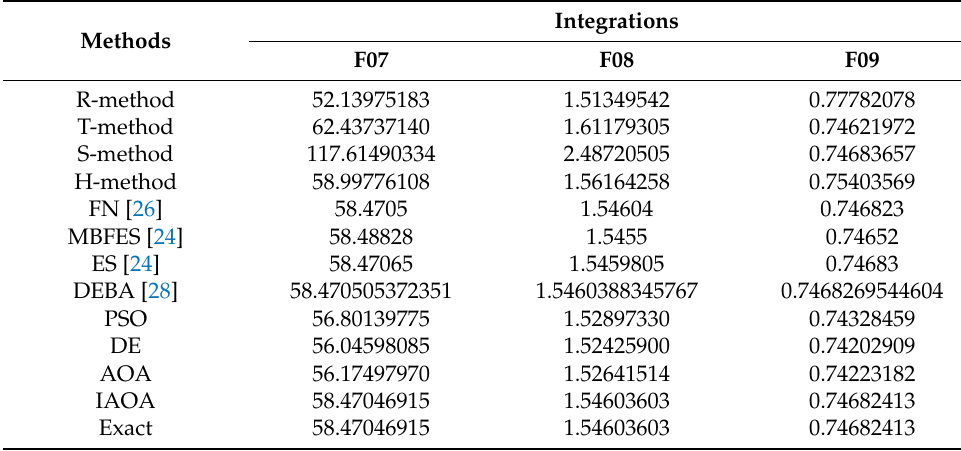
Table 11. Comparison of the experimental results for F07–F09.